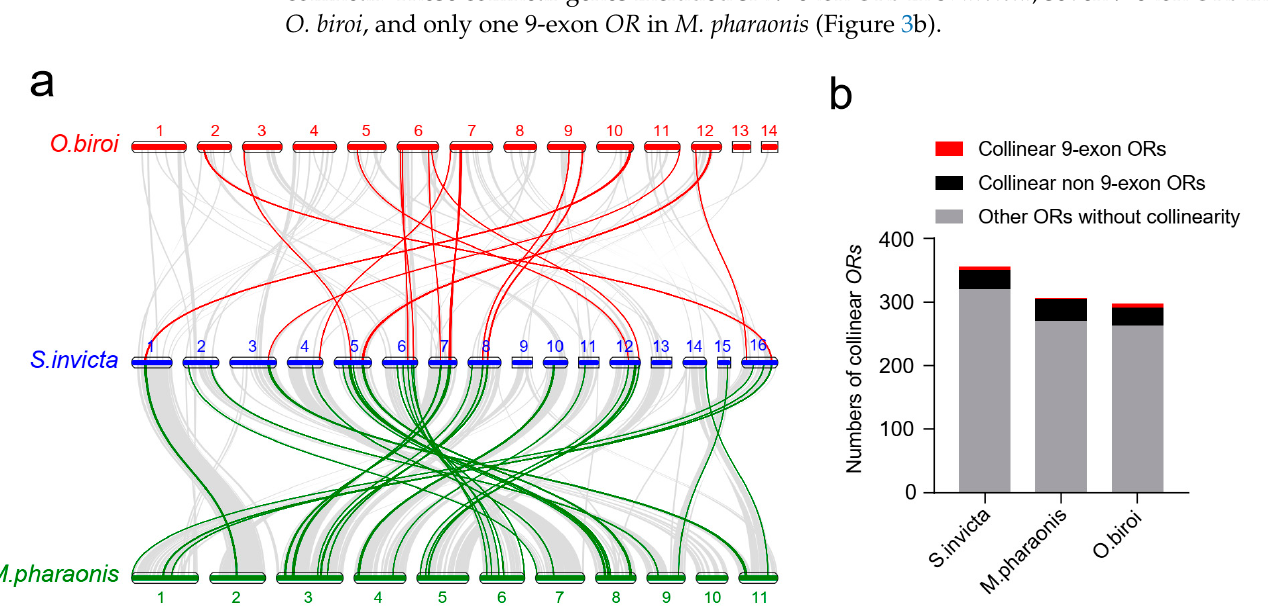
Figure 3. Synteny of OR genes in three Formicidae species. ( a ) Genome synteny of ORs. S. invicta chromosomes are labeled in blue, O. biroi in red, and M. pharaonis in green. Syntenic OR genes between S. invicta and O. biroi are connected with a solid red line, and those between S. invicta and M. pharaonis are connected with a solid green line. Other syntenic genes are connected by a solid gray line. ( b ) Numbers of collinear ORs in three Formicidae ant species. The numbers in gray bars represent the ORs without genomic collinearity (all other ORs ), while numbers in red bars (9-exon ORs ) and black bars (non-9-exon ORs ) represent all collinear ORs in the three ant species .